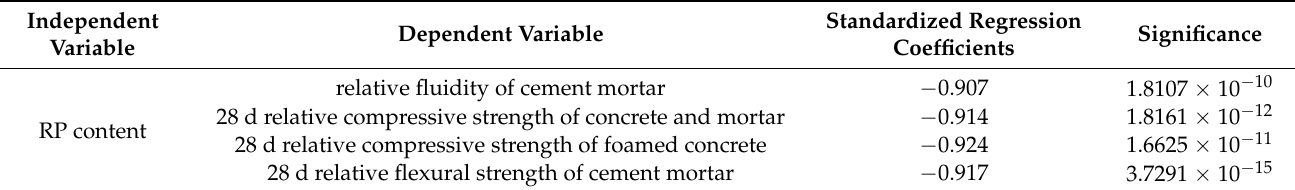
Table 4. Standardized regression coefficients.